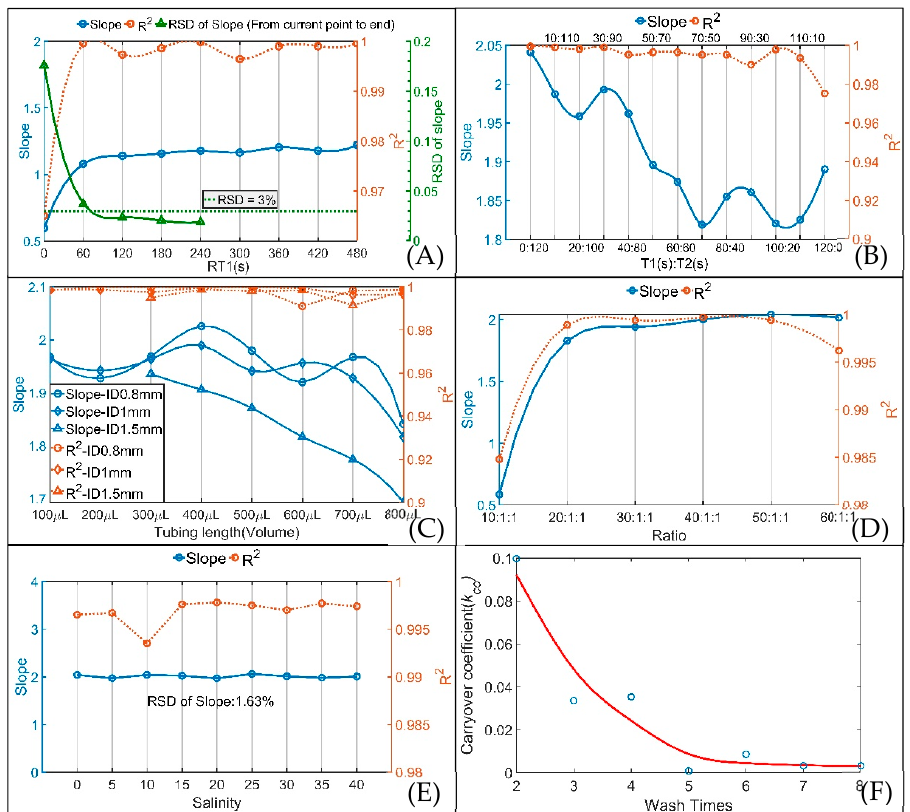
and Figure 4C. By analyzing the slopes of all curve fittings, the slopes for the 0.8 mm I.D. were larger overall than the other slopes, and the maximum slope for the 0.8 mm I.D. occurs at 400 μ L. Therefore, the combination of the 796 mm tube length (corresponding volume is 400 μ L) and 0.8 mm tube I.D. was optimal for the SIA system.